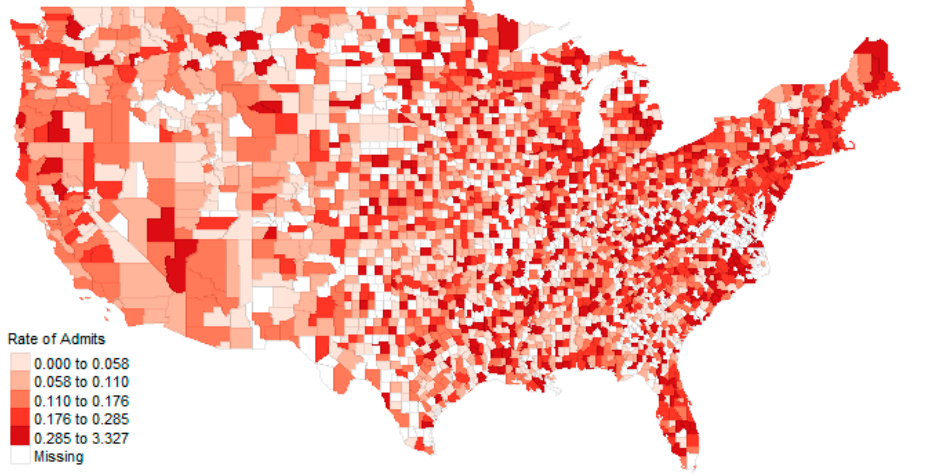
Figure 14. The admission rate from 2016 through 2018 by county.